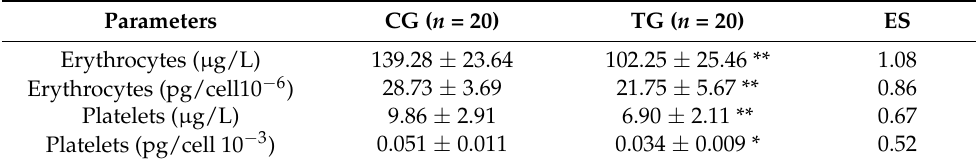
Table 5. Se concentrations in erythrocytes and